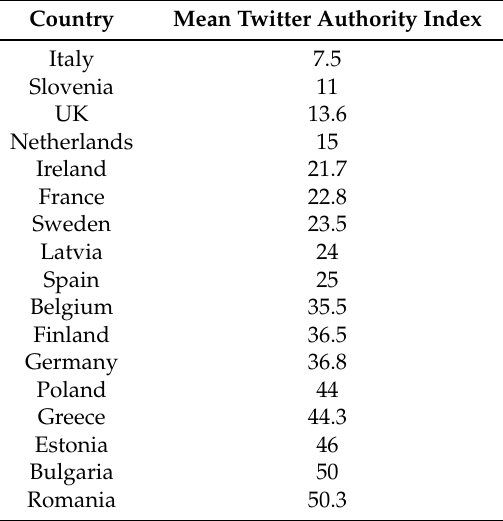
Table 6. Mean Twitter Authority Indexes by